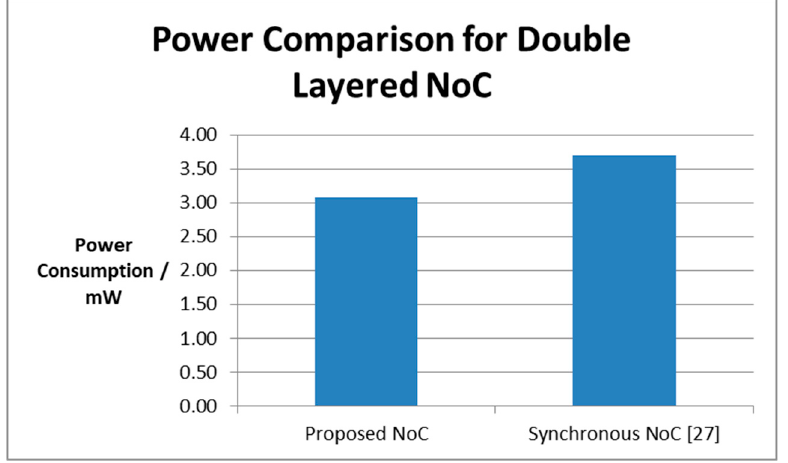
Table 2. Hierarchical power analysis for the proposed double-layer NoC. Hierarchy Table 2. This indicated that the asynchronous data layer had the smallest power contri- bution within the overall structure, whereas the synchronous layer had the largest power contribution. This is the tradeoff between the fast layer with high power consumption and the slow layer with efficient power consumption. The overall power consumption of the proposed architecture was compared with the design presented in [27]. The results showed that the overall power consumption for the proposed design was reduced by 23% when compared with the fully synchronous design.